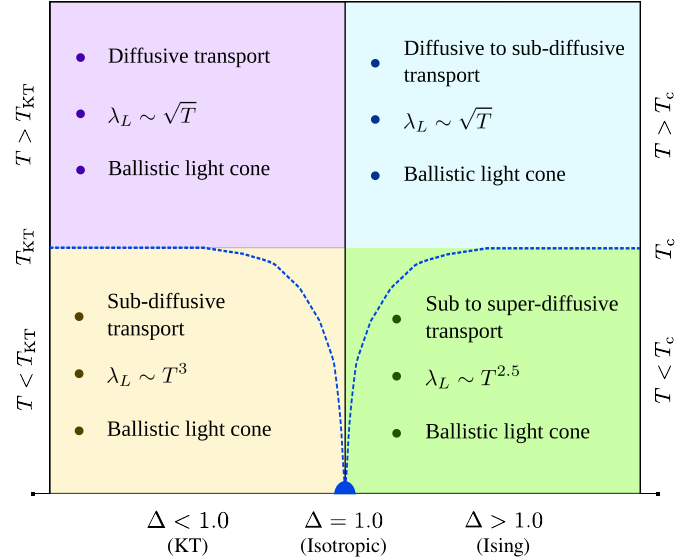
Figure 1: Phase diagram: Schematic phase diagram showing dynamical transitions and / or crossovers in terms of chaos and transport across KT and Ising transitions for easy-plane ( ∆ < 1) and easy-axis ( ∆ > 1)